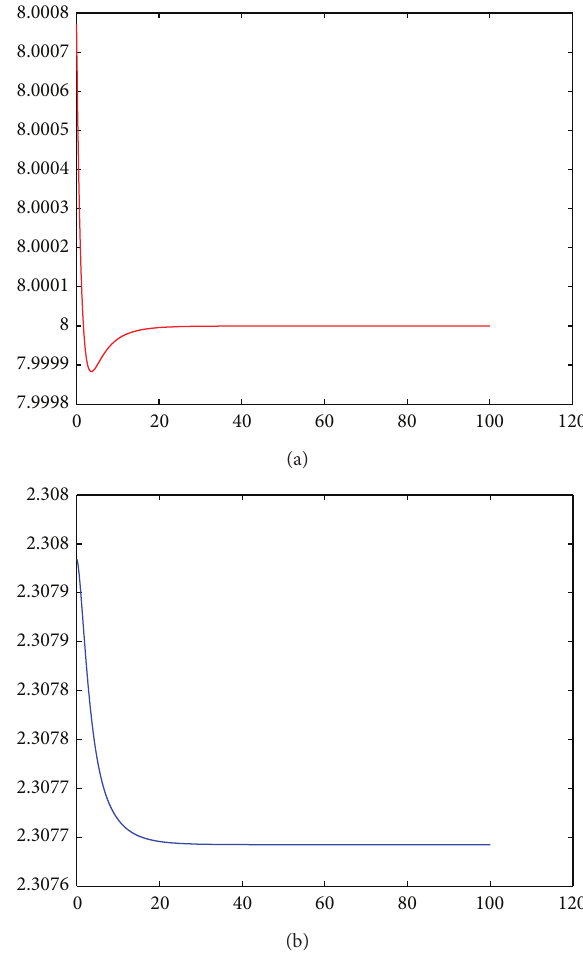
Figure 3: Time evolution of (4) around the interior equilibrium (8, 2.30769) . Phytoplankton is in (a) and zooplankton is in (b). The parameter values are 𝑑 1 = 0.001 , 𝑑 2 = 0.004 , 𝑒 = 0.5 , 𝑎 = 0.1 , 𝑛 = 5 , 𝑚 = 0.5 , 𝜇 = 0.4 , 𝑟 = 2 , and 𝐾 = 10 . The figure shows that both types of plankton exhibit stable